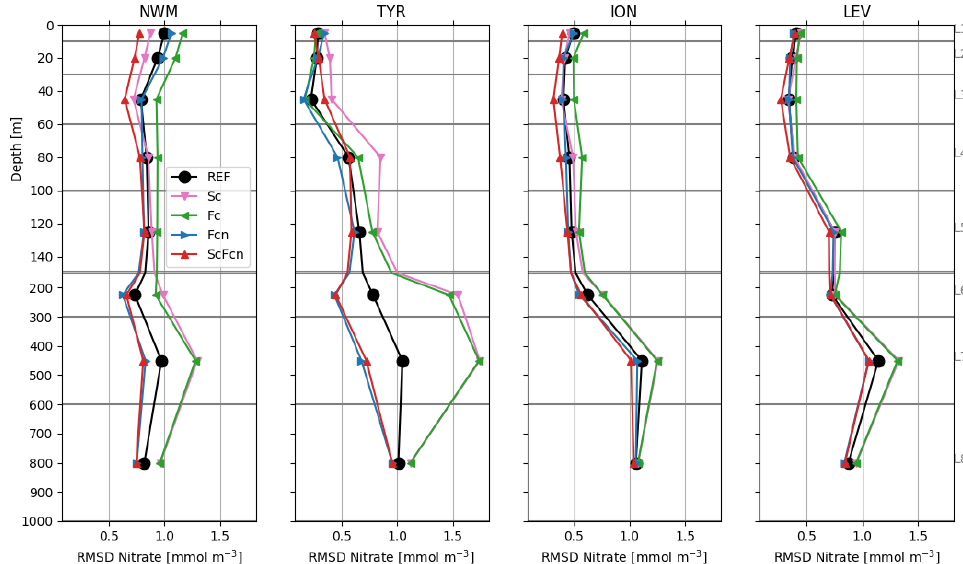
Figure 3. RMSD between model simulations and BGC-Argo nitrate data in four sub-basins (Fig. 1). Grey lines indicate the limits of layers L1–L8 (Table 2) used to calculate the RMSD. The depth scale is different above and below 150m (thick grey